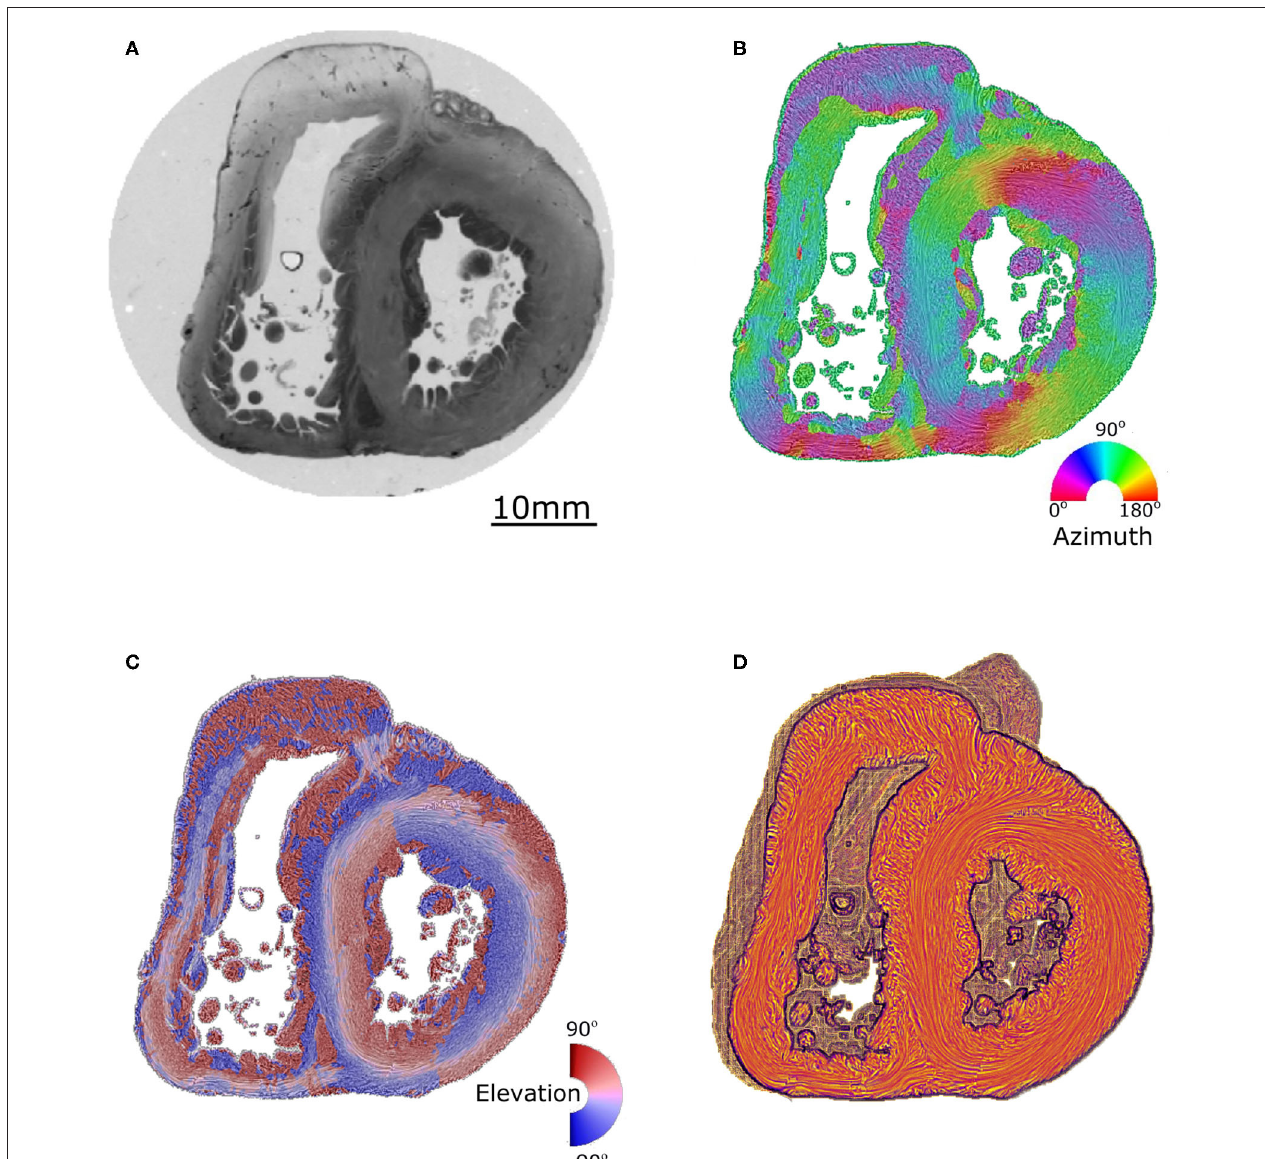
FIGURE 1 | Illustration of the different maps obtained by PLI. (A) Short-axis section (500 µ m thickness) made after resin embedding and viewed in transmitted light. (B) False color azimuth map of the section with superimposition of LIC texture (0–180 ◦ range). (C) False color elevation map with superimposition of LIC texture ( − 90 to + 90 ◦ range). (D) Orientation map limited to “streamlines” representation in LIC texture. The virtual dissection plan is false-colored in orange-brown, with the surface of the basal ventricular mass in